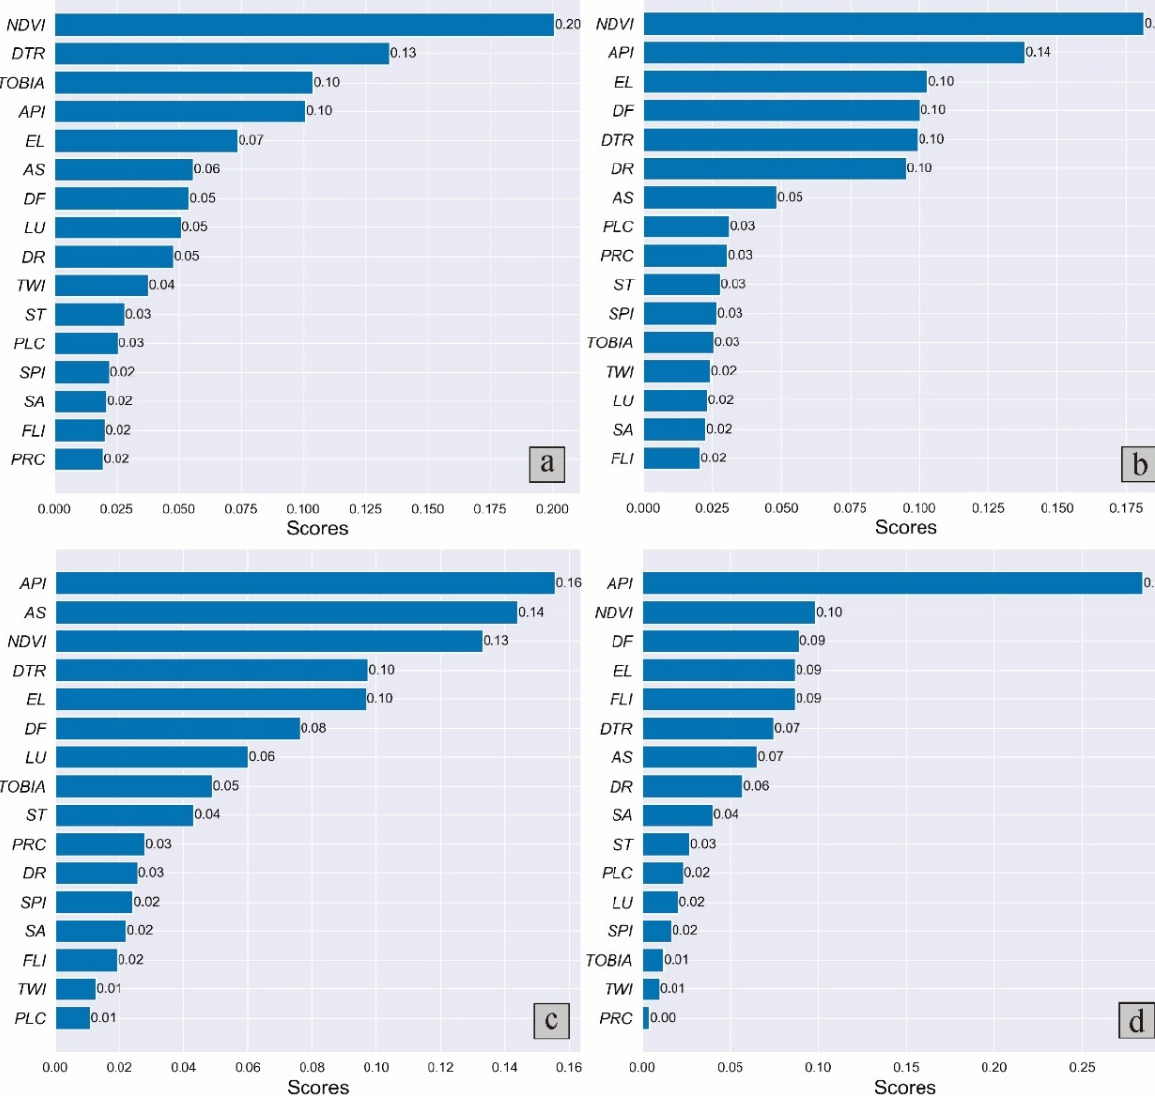
Figure 9. Box plots of the correlation factors for the unclassified landslide database. NLS non-landslides, LS landslide.